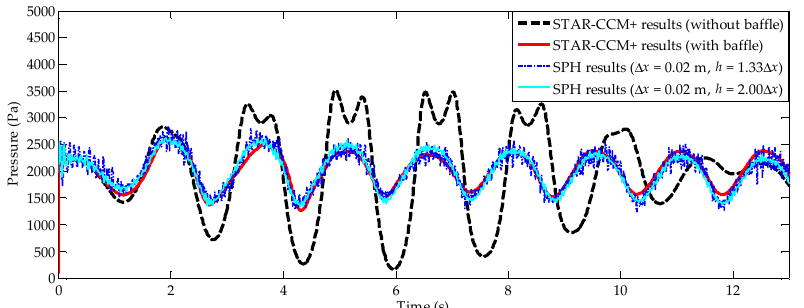
Figure 36. Comparison of the pressure on the solid boundary obtained by the SPH and STAR-CCM+ simulations.